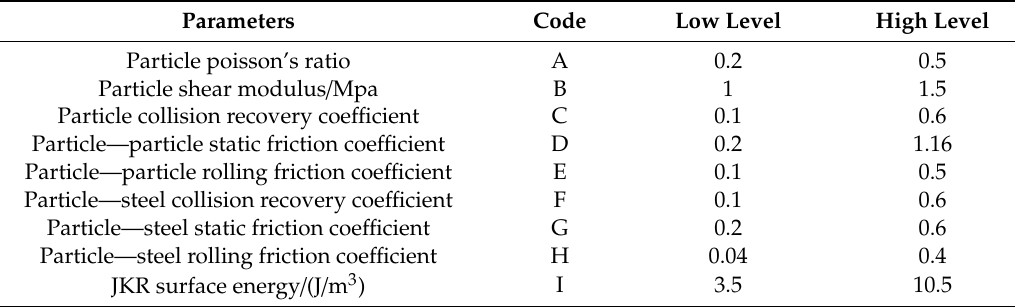
Table 3. Discrete element parameter